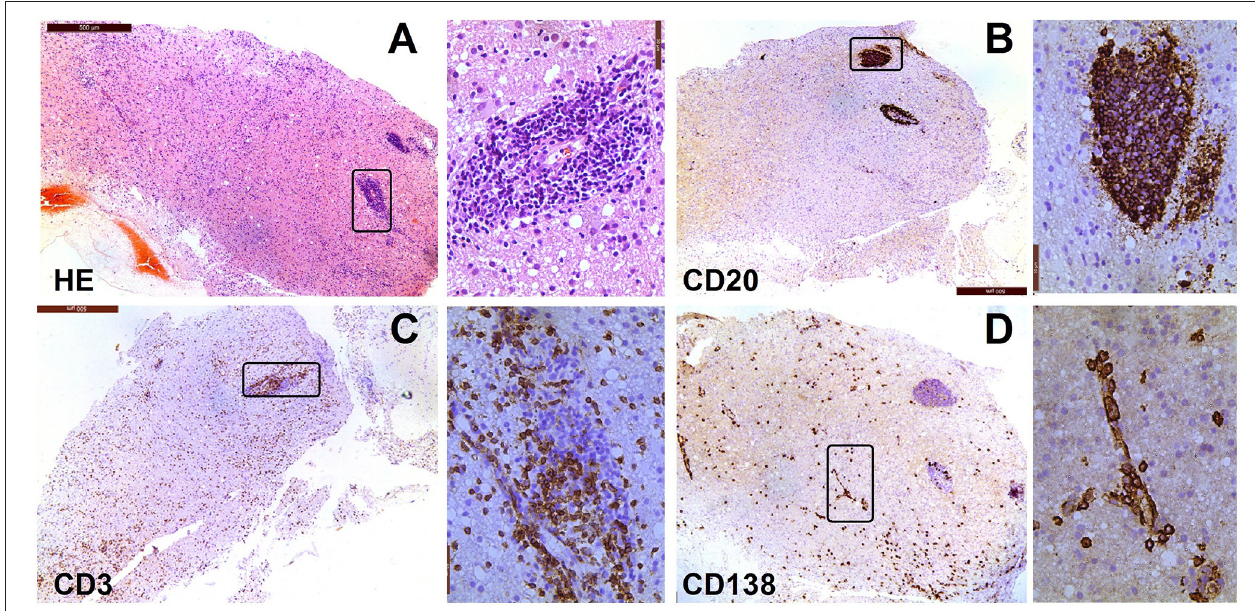
FIGURE 3 | Neuropathological features of a patient with encephalitis. The case involved a woman, whose age at onset was 69 years. In January 2015, she experienced psychosis, dyskinesia, persistent fever, and paralysis of a right-side limb. Antibody detection and biopsy were conducted before the IVMP and IVIG treatment. She then received treatment with methylprednisolone and azathioprine. She did not response well to this treatment and died of acute respiratory failure 1 year later. (A) Hematoxylin-eosin staining of brain biopsy tissue shows extensive infiltration of inflammatory cells; (B) Immunostaining for anti-CD20 is mainly around the vessels in lesions; (C) Immunostaining for anti-CD3 is sparse throughout the lesion, with some staining around the large vessel; (D) CD138 + cells are present in perivascular, Virchow–Robin, and interstitial